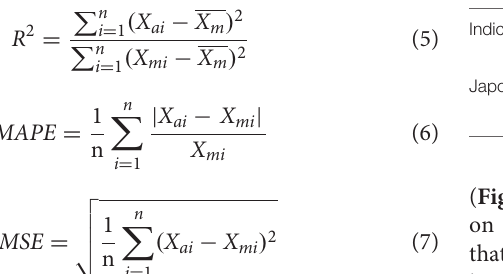
TABLE 1 | The performance of the threshed panicle identification models.